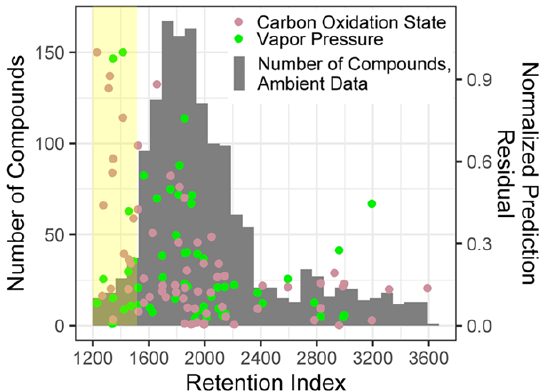
Figure A4. Quantification factor prediction errors expressed in log(predicted quantification factor/true quantification factor) for test set quantification factors predicted by the random forest model (or- ange), closest proxy, and manual proxy